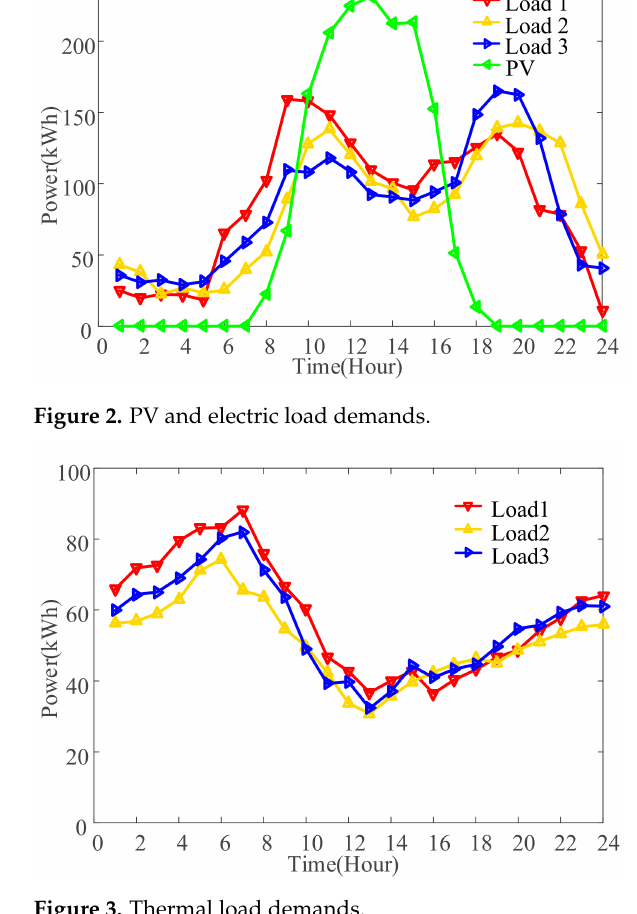
Figure 3. Thermal load demands. Table 1. TOU prices of utility